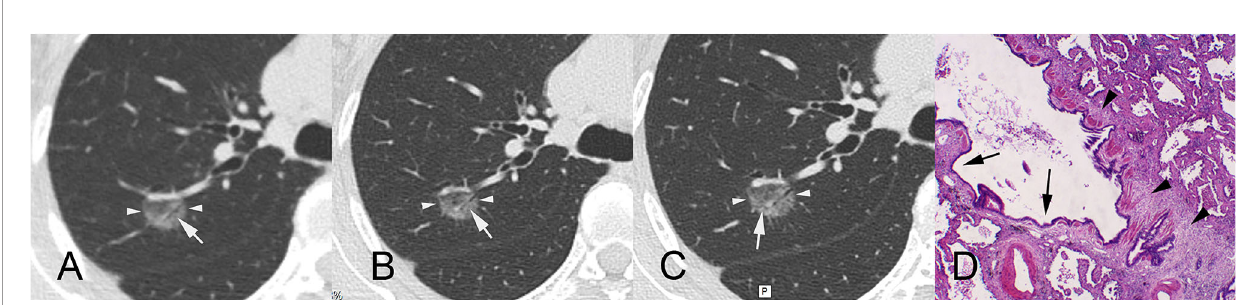
FIGURE 3 | A 55-year-old female patient with ground-glass nodules in the posterior segment of the right upper lobe detected by LDCT screening. AI indicated that the malignant rate was 97.46%. Surgical resection revealed invasive mural adenocarcinoma. CT images reconstructed by lung window. (A) LDCT image. The white arrow indicates that there is an obscure air bronchogram in the nodule. (B) Conventional CT image. The white arrow indicates a slightly clear air bronchogram in the nodule. (C) HRCT local-target scanning image. An abnormal air bronchogram is visible. The white arrow indicates that the target scan shows a fi ner tortuous bronchial sign. (D) Pathological HE staining image (×40) showing diffuse tumour tissue around bronchioles, in fi ltration and growth of tumour tissue, and proliferation of fi brous connective tissue (arrowheads), resulting in bronchiectasis (arrows). AI, arti fi cial intelligence; LDCT, low-dose computed tomography; CT, computed tomography; HRCT, high-resolution computed